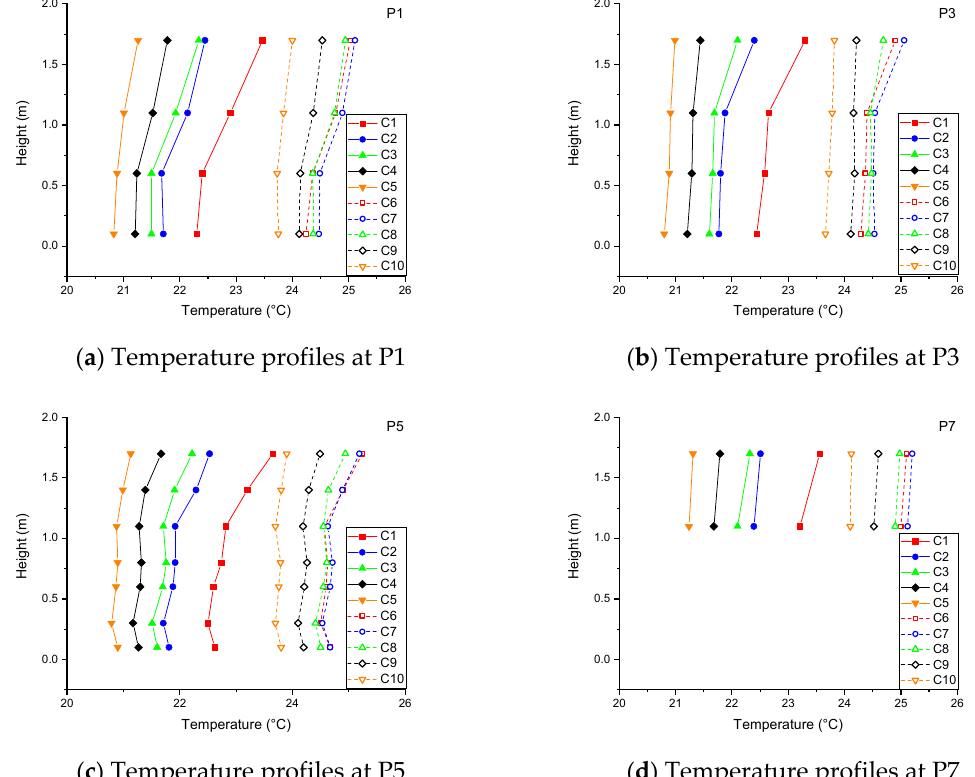
Figure 4. Air temperature profiles at position P1 ( a ), P3 ( b ), P5 ( c ) and P7 ( d ) for cooling cases (C1– C10).